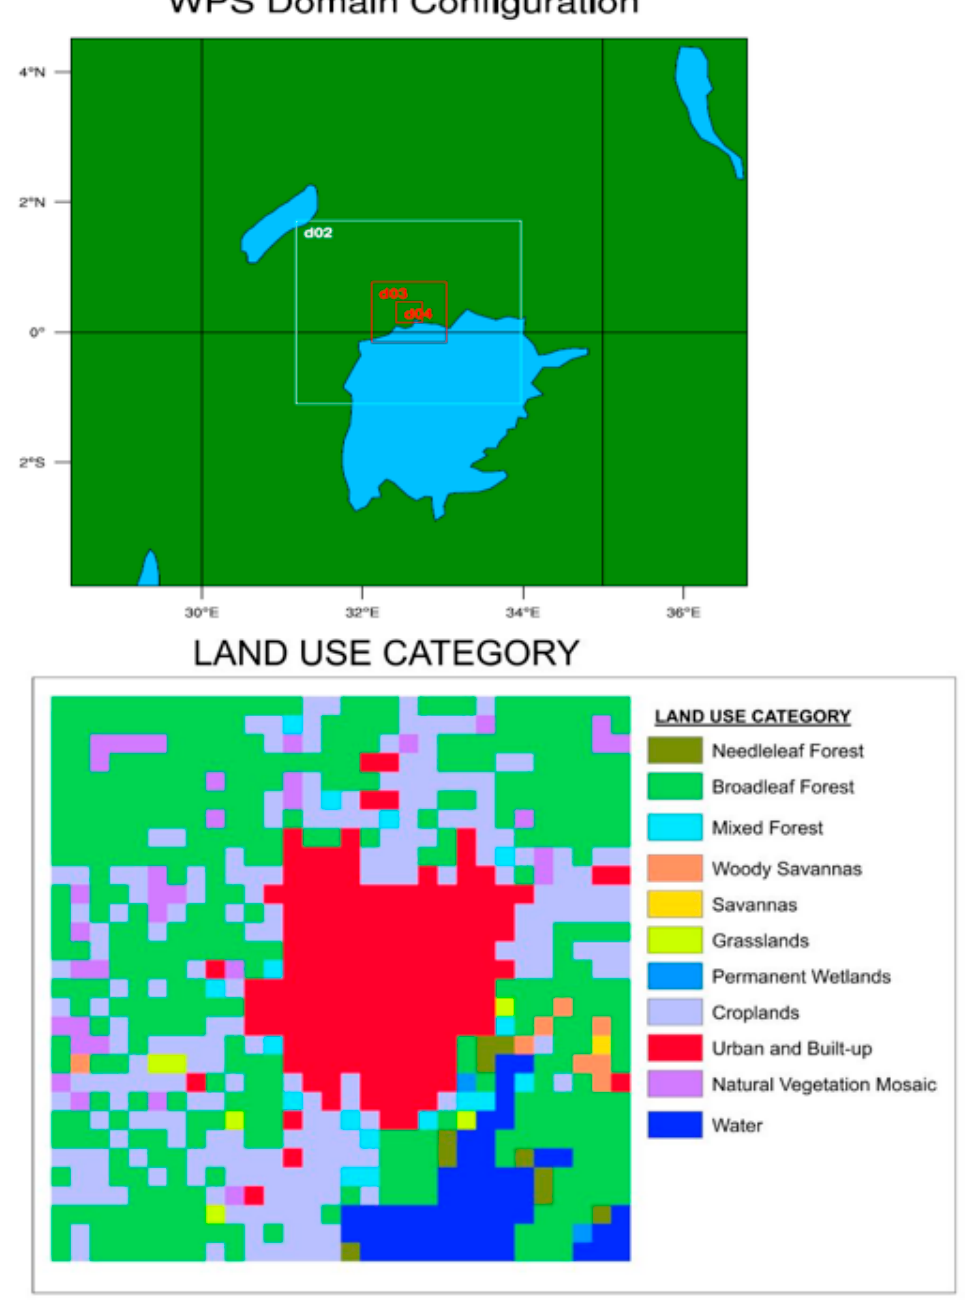
Figure 2. Upper: The Weather Research and Forecasting (WRF) model configuration using four domains (d01, d02, d03, and d04); Bottom: Land-use categories and the default urban fraction representation (RED POLYGON) in the innermost domain d04 of WRF.